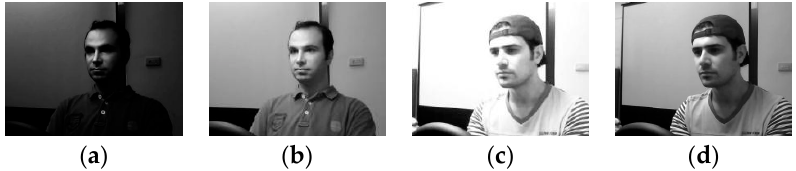
Figure 6. Original and gamma correction renderings. ( a ) Underexposed image. ( b ) Underexposed image after gamma correction. ( c ) Overexposed image. ( d ) Overexposed image after gamma correction.